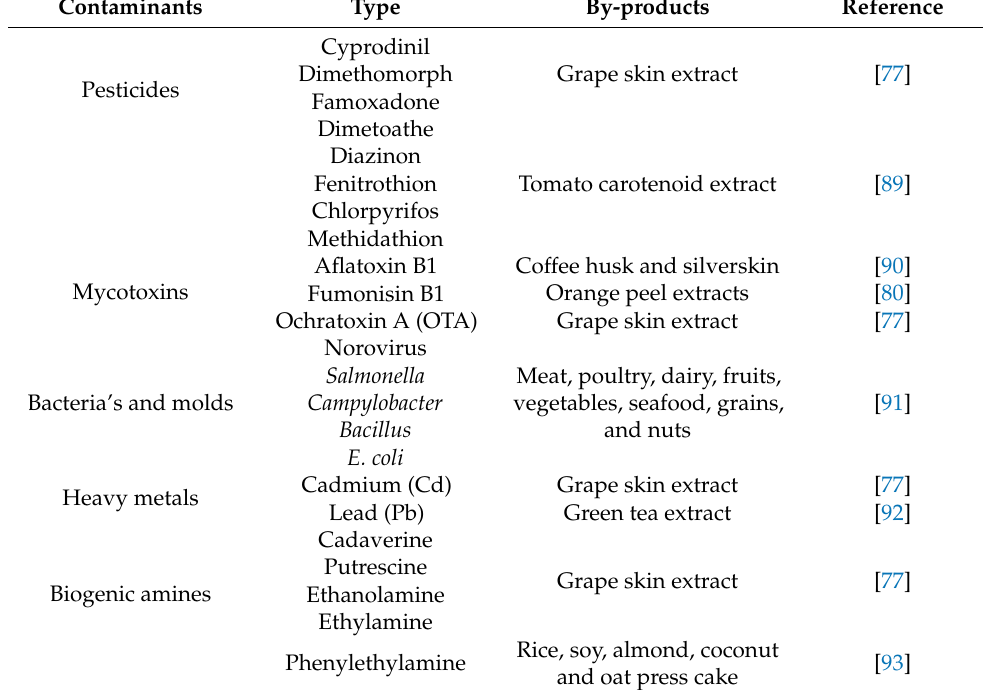
Table 1. Examples of potential safety hazards related with agro-food by-products